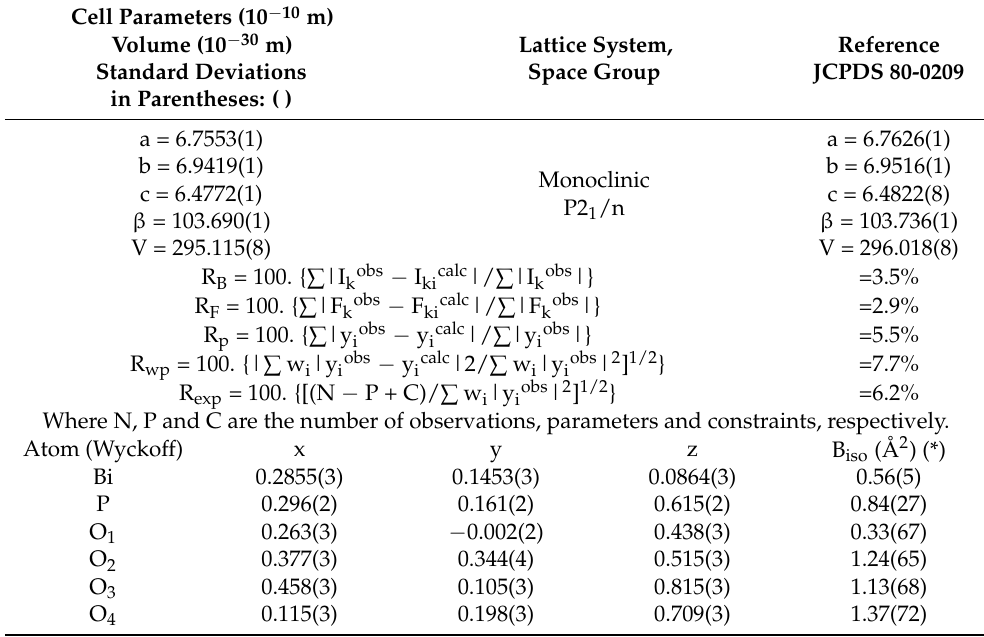
Figure 2. ( a ) XRD pattern of monoclinic BiPO 4 (space group P2 1 /n). ( b ) Results of Rietveld refinement calculations for the monoclinic BiP-500 compound. Table 1. X-ray diffraction results at 25 °C: Rietveld structure refinement of the BiPO 4 phase thermally treated at 500 °C.